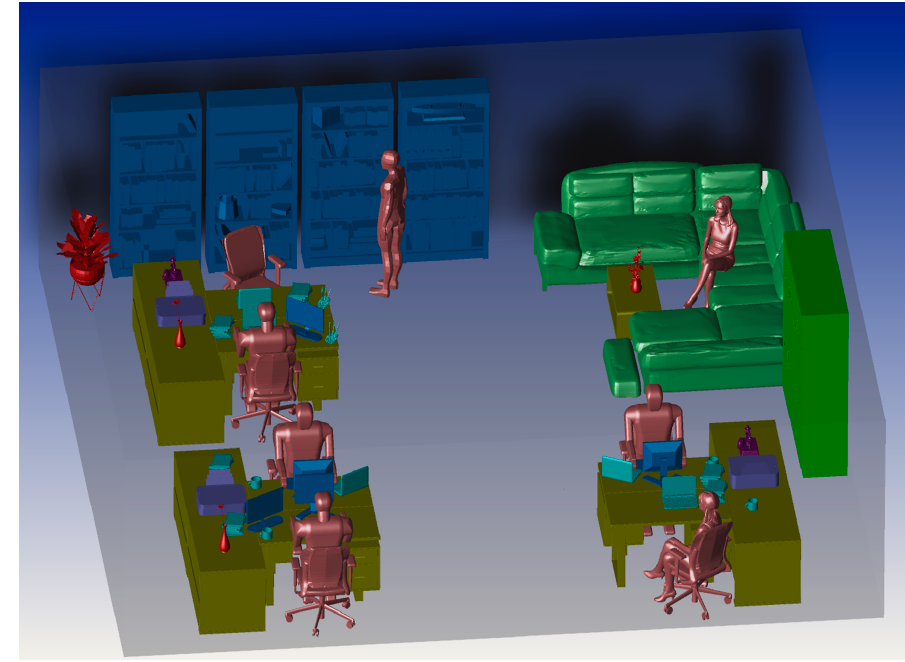
Figure 2. The three-dimensional office environment. Sensors 2020 , 20 , x FOR PEER REVIEW